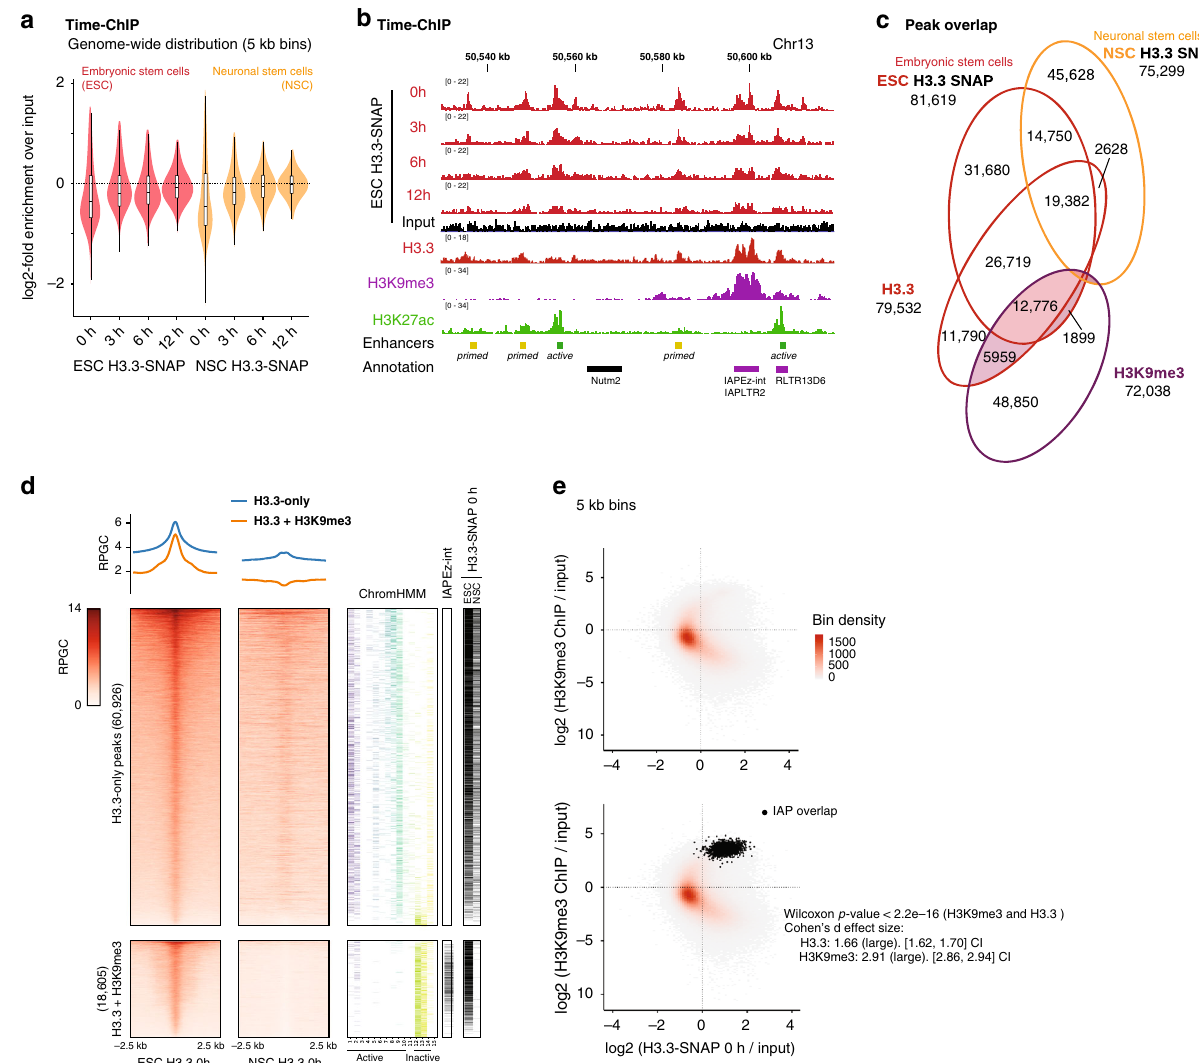
Fig. 1 Ectopic H3.3-SNAP shows ESC-speci fi c enrichment at interstitial heterochromatin. a Violin plots showing genome-wide distribution of biotin- labeled H3.3-SNAP 9 in 5 kb windows, in mouse embryonic stem cells (ESC) and neuronal stem cells (NSC). Biotin labeling of H3.3-SNAP was performed at 0 h and followed over subsequent 3, 6, and 12 h 9 . Each datapoint is calculated as the log2 value of the mean coverage in each sample bin divided by the mean coverage value of its corresponding input sample bin. Data shown from n = 1 biological replicate. Source data are provided as a Source data fi le. b Genome tracks showing example region of time-ChIP 9 in ESC showing overlap of H3.3-SNAP and endogenous H3.3 21 with H3K27ac 20 at enhancers and H3K9me3 71 at IAP ERVs. All tracks were normalized to Reads Per Genomic Content (RPGC). See also Supplementary Fig. 1 for controls and additional tracks. c Venn diagrams showing overlap of H3.3-SNAP 0 h 9 peaks with endogenous H3.3 peaks in ESC 21 , H3K9me3 71 , and H3.3-SNAP 0 h peaks in NSC 9 . d Read density heatmaps and average pro fi les of H3.3-SNAP in ESC and NSC, at ESC H3.3 peaks 21 . Peaks were separated in two categories, H3.3-only and H3.3 + H3K9me3, according to coincidence with H3K9me3 peaks 21 . Overlap with 15 ChromHMM states 37 , IAP ERV elements (from RepeatMasker) and H3.3-SNAP peaks in ESC and NSC is shown as additional heatmaps where the coincidence with a chromatin state or peak from the respective annotation set is indicated with a colored or black line. e Scatter plot showing relationship between H3.3 21 and H3K9me3 71 assessed over 5 kb bins genome-wide. Color scale represents density of underlying data points (5 kb bins). Bottom graph shows bins overlapping with IAP ERVs in black. Two-sided Wilcoxon rank sum ( p < 2.2e − 16 ) and Cohen ’ s effect size d (H3.3: 1.66 + / − 0.04; H3K9me3: 2.91 ± 0.05) tests show signi fi cant enrichment for both at H3.3 and H3K9me3 in these 5 kb bins. Overlap with additional repeat families are shown in Supplementary Fig. 3. Source data are provided as a Source data fi